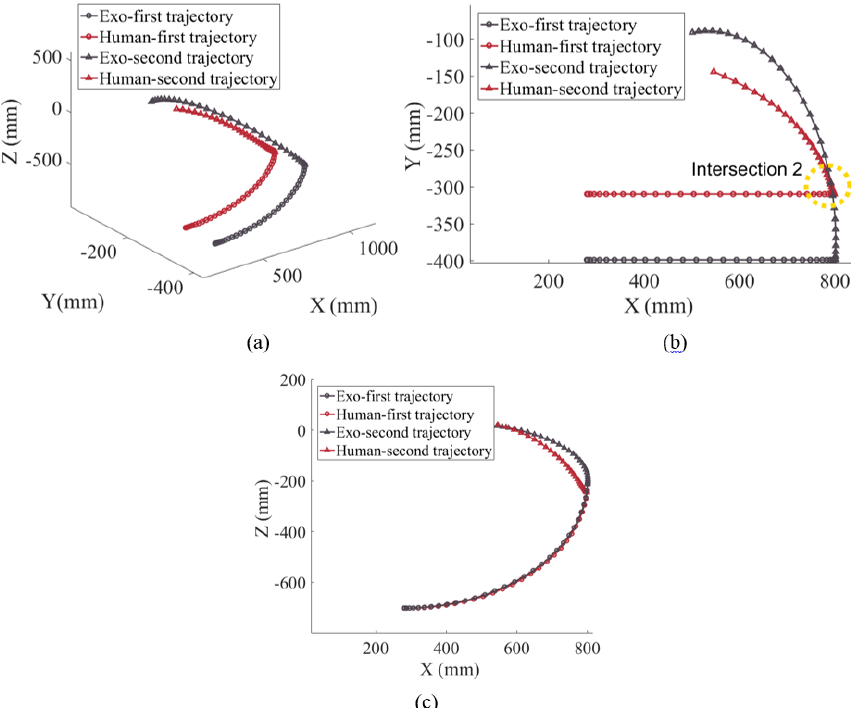
Figure 17. The improved drinking trajectories of the exoskeleton and human. (a) Three-dimensional view. (b) Horizontal plane view. (c) Sagittal plane view.